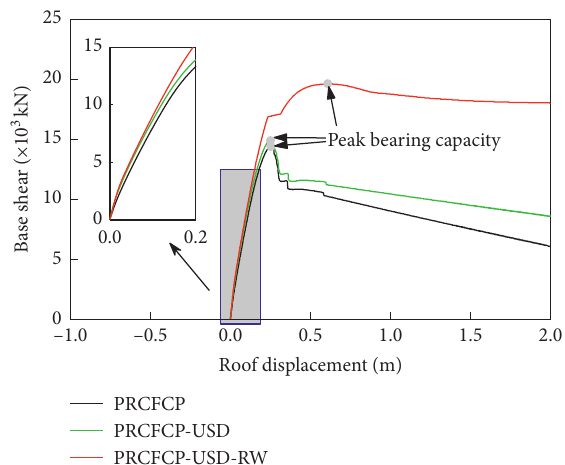
Figure 8: Curves of the base shear force and roof